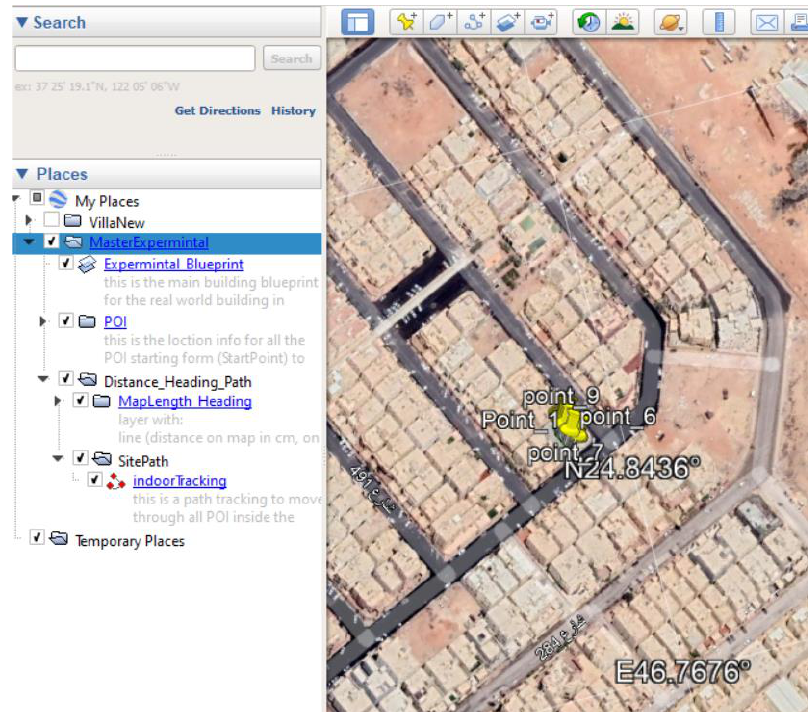
Figure 24. Building location on a map.